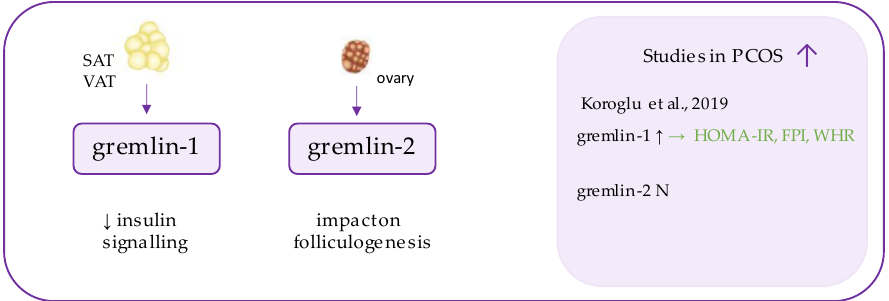
Figure 5. Role of gremlin in the pathogenesis of insulin resistance and PCOS. List of the studies assessing gremlins level in serum of the patients with PCOS. ↑ /N indicates whether concentration level of gremlin was increased/unchanged in PCOS individuals ( p < 0.05); → (green)—indicates positive correlation between serum omentin and particular indicators; HOMA-IR—Homeostatic Model Assessment for Insulin Resistance, FPI—fasting plasma insulin, WHR—waist-to-hip ratio.